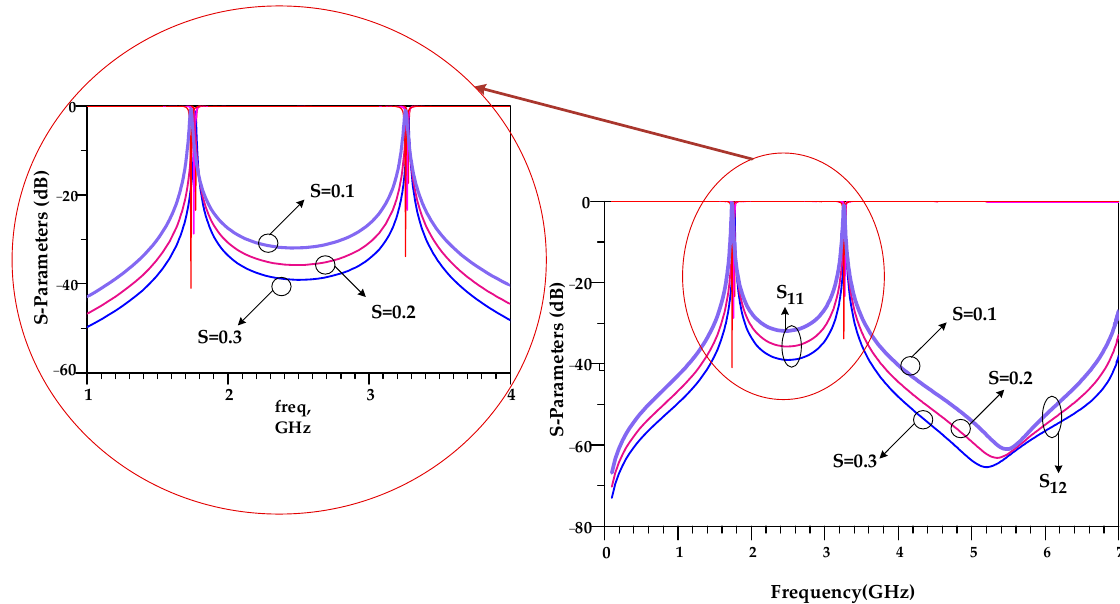
Figure 5. Effects of gap space (S) in the first proposed BPF at 1.9/3.6 GHz.